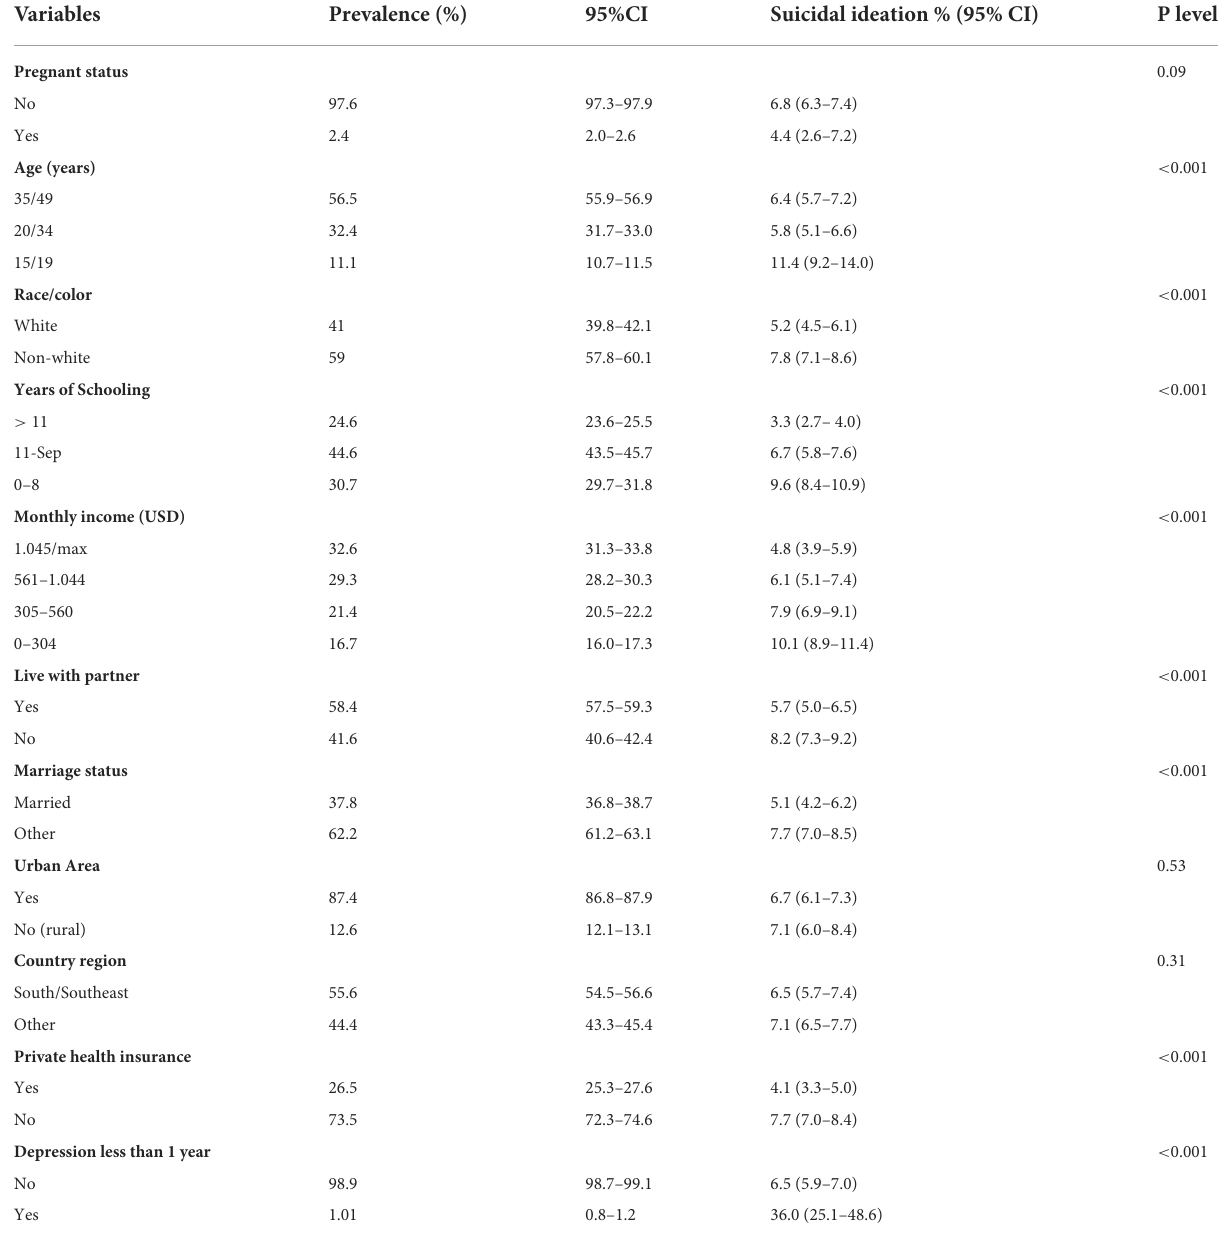
TABLE 1 Women characteristics according to suicidal ideation in the National Health Survey, Brazil